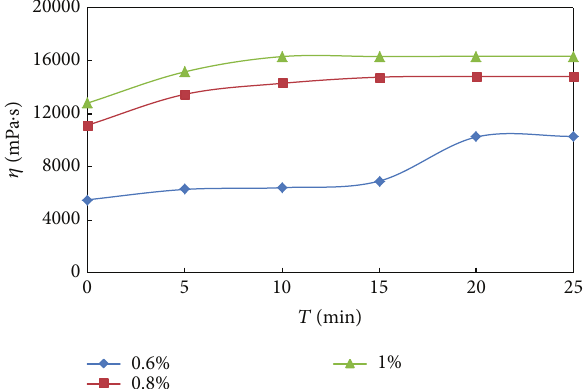
Figure4:Relationshipbetweenmassfractionofblendsandgelation time of foamed